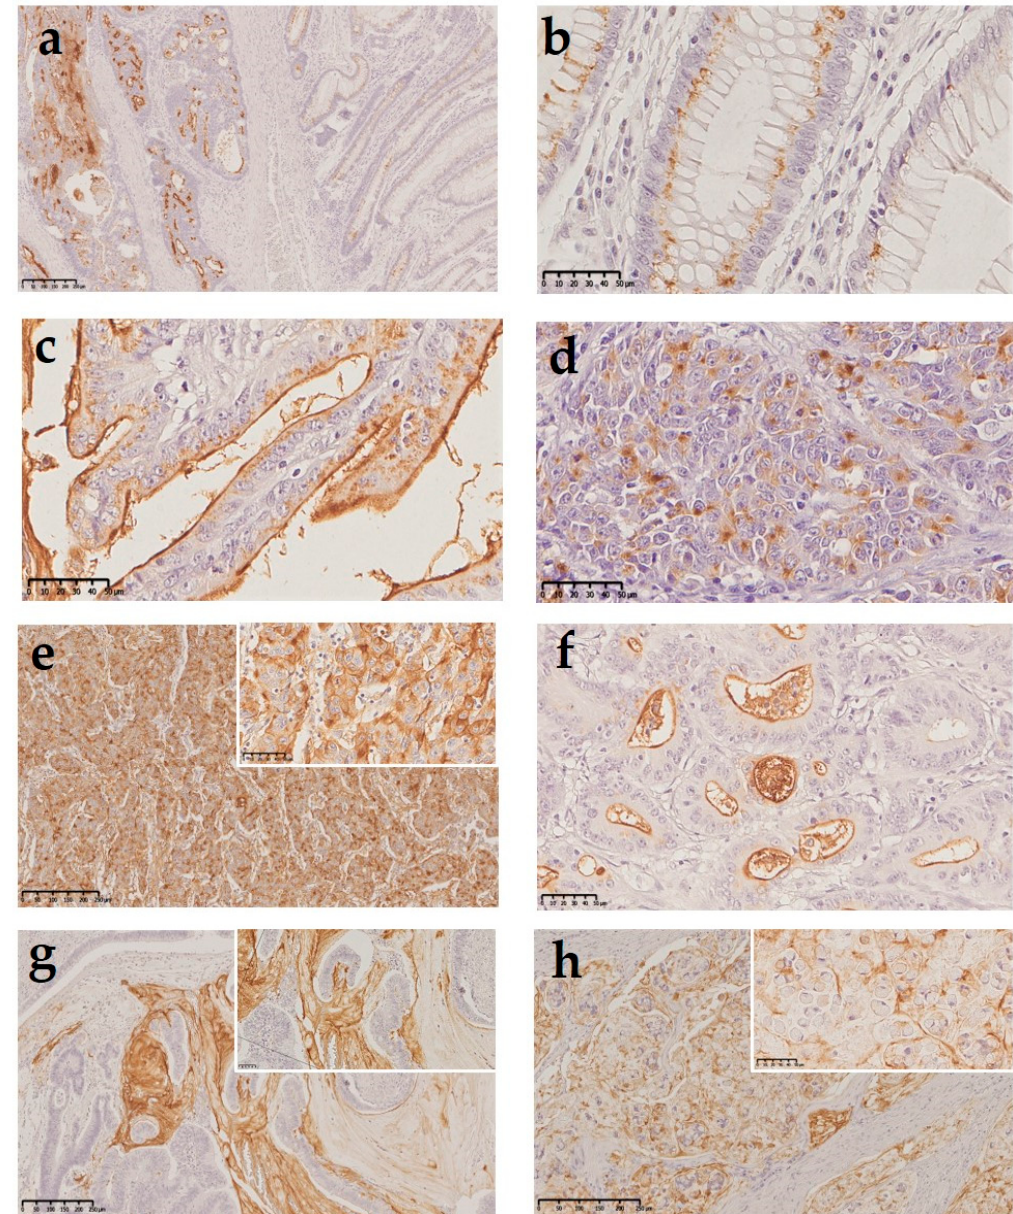
Figure 1. Thomsen–Friedenreich antigen (TF) expression in human colorectal tissue samples: ( a ) colorectal adenocarcinoma (left) and nonneoplastic mucosa adjacent to the tumor (right), both expressing the TF antigen (100× magnification); ( b ) high power of the nonneoplastic mucosa displaying perinuclear staining of the TF antigen in the Golgi apparatus (400× magnification); ( c ) strong expression in the apical membrane in a low-grade carcinoma (400× magnification); ( d ) cytoplasmatic staining in a high-grade carcinoma with a solid tumoral component (400× magnification); ( e ) cytoplasmatic and membranous staining in a high-grade adenocarcinoma with trabecular structure (200× magnification—insert 400×); ( f ) TF expression in intraglandular mucus in a low-grade adenocarcinoma (400× magnification); ( g ) TF expression in mucin pools in the mucinous component of a low-grade adenocarcinoma (50× magnification—insert 400×); and ( h ) TF expression in signet ring cells (100× magnification—insert 400×).